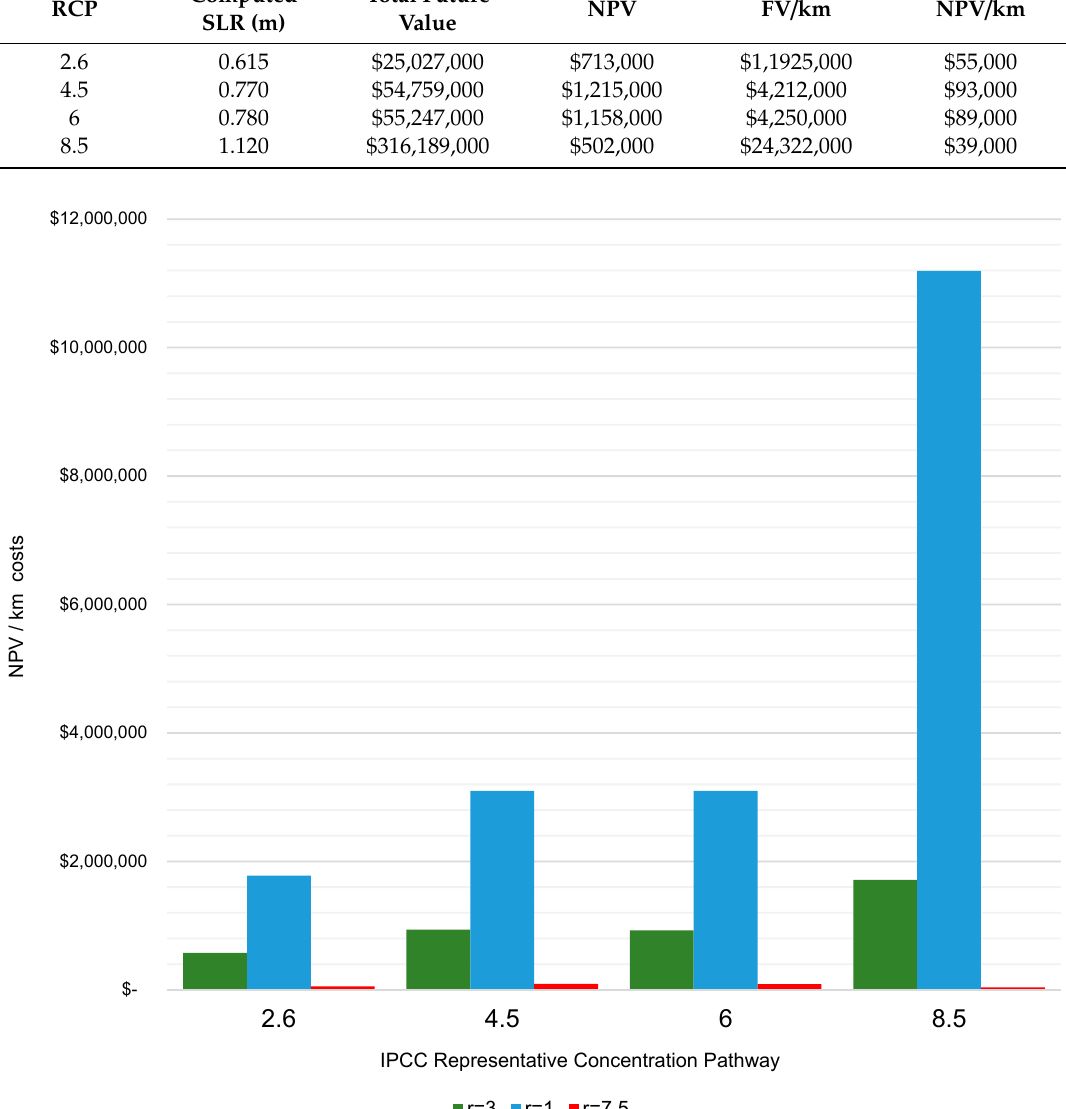
Figure 4. Derived net present value / km of coastline defensive adaptation approach to climate change adaptation for the southern Gold Coast.